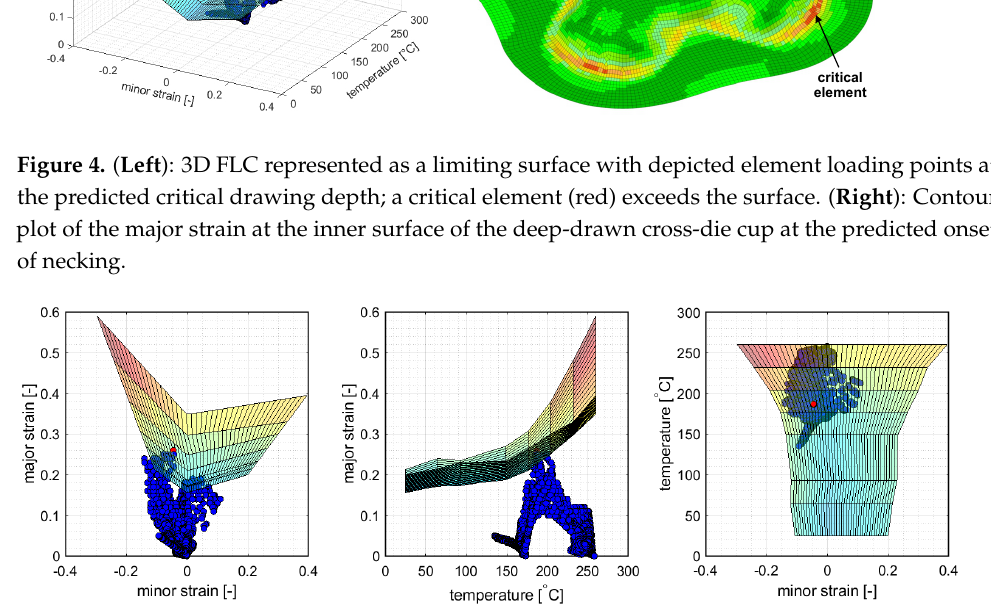
Figure 5. The 3D FLC at the predicted onset of necking from Figure 4 depicted in different